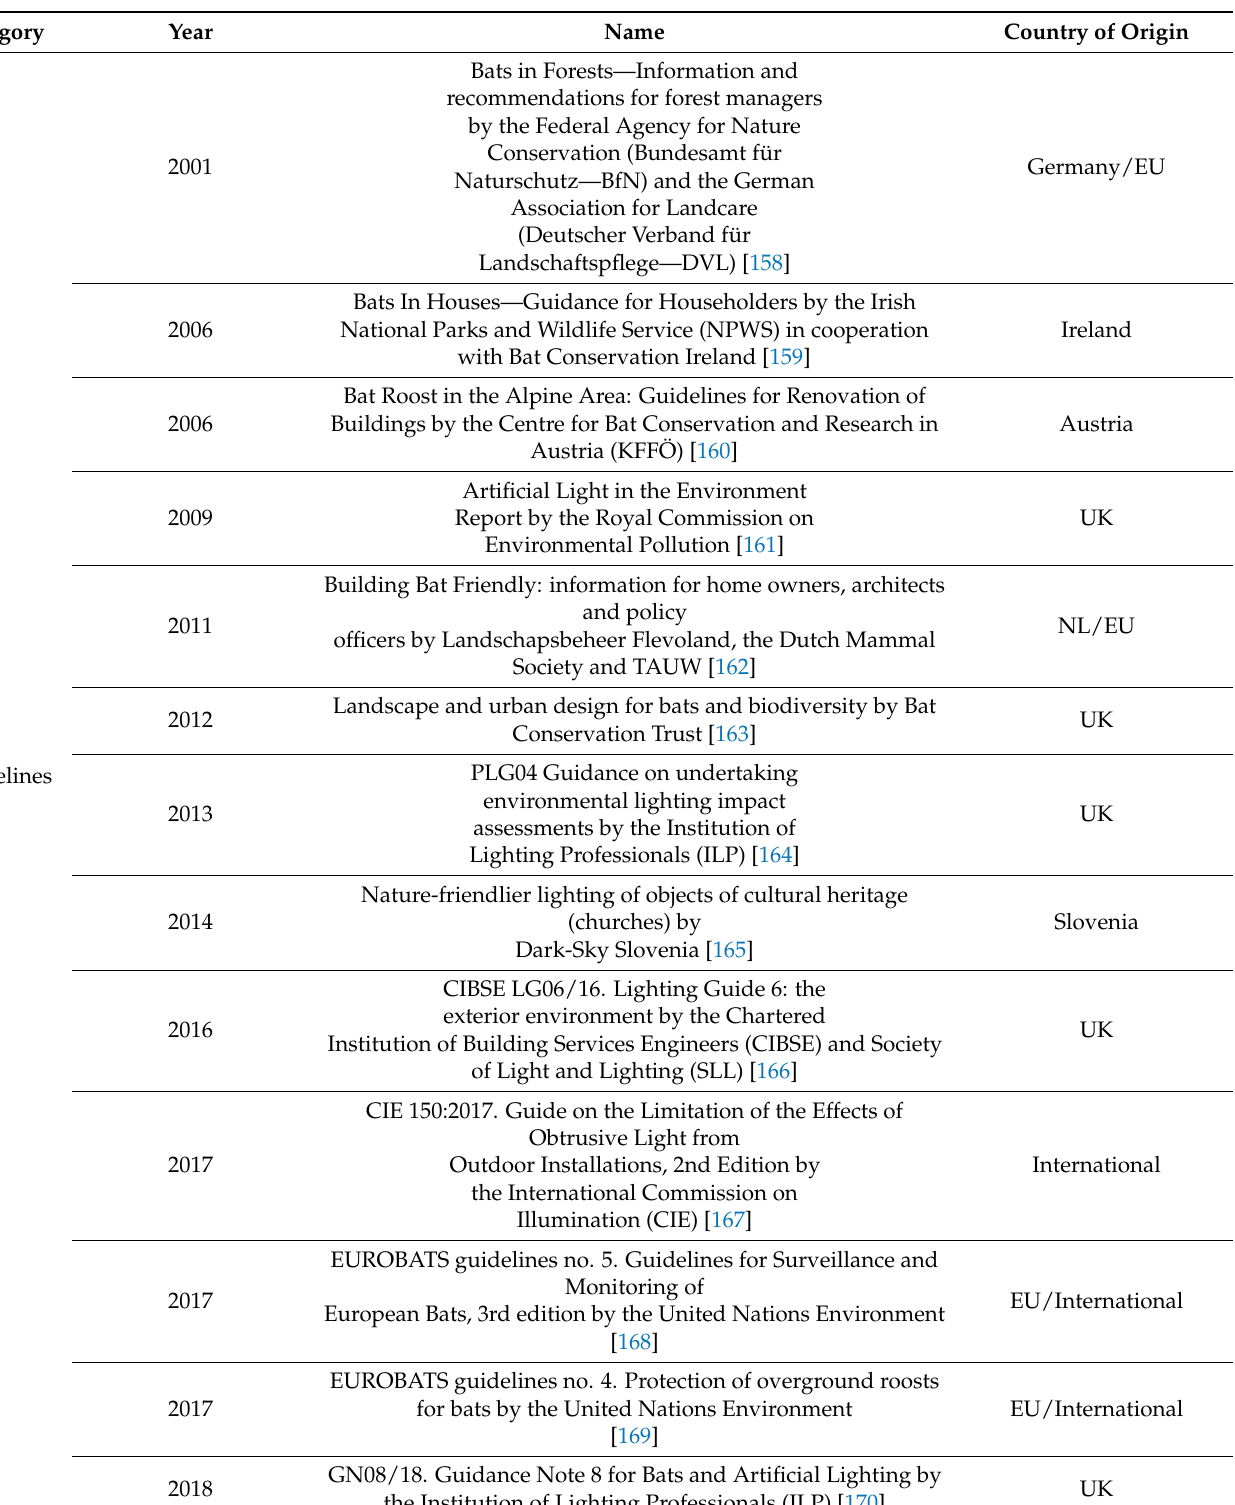
Table A2. Examples of regulatory frameworks on ALAN in the context of environmental protection and bats. Source: authors’